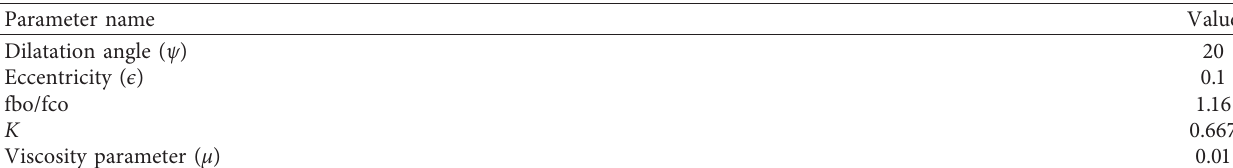
Table 7: Default parameters of concrete damage plasticity model [25].